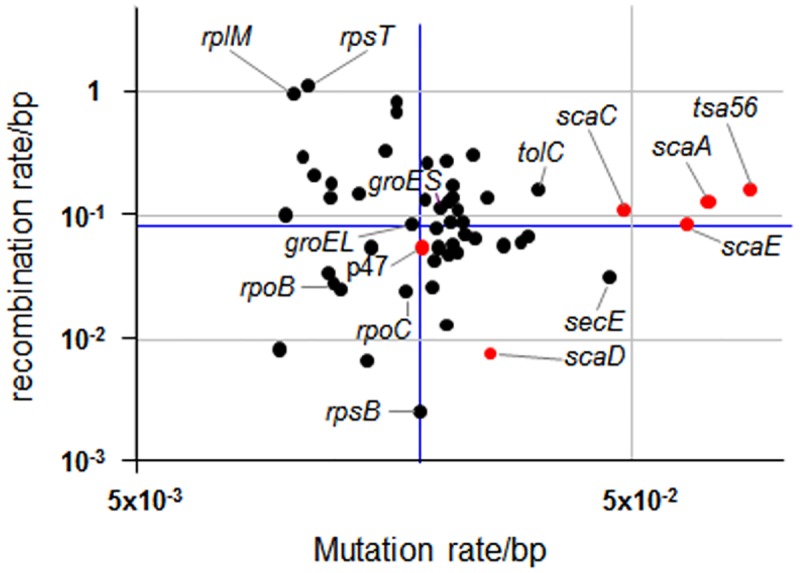
Estimation of recombination and mutation rates of O. tsutsugamushi genes.Recombination and mutation rate per site of 53 genes were calculated by LDhat installed in RDP program. Sequences of 53 gene sets were extracted from nine O. tsutsugamushi genomes available in NCBI database. Average recombination rate per base pair (ρ/bp) of 53 gene sets is 0.083 and average mutation rate per base pair (θ/bp) is 0.020 (blue lines). Genes encoding known membrane proteins are indicated as red dots. Detailed information of the gene sets is presented in S7 Table.